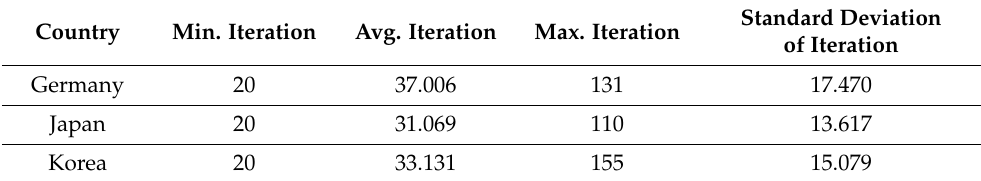
Table A4. The iteration number of three countries.